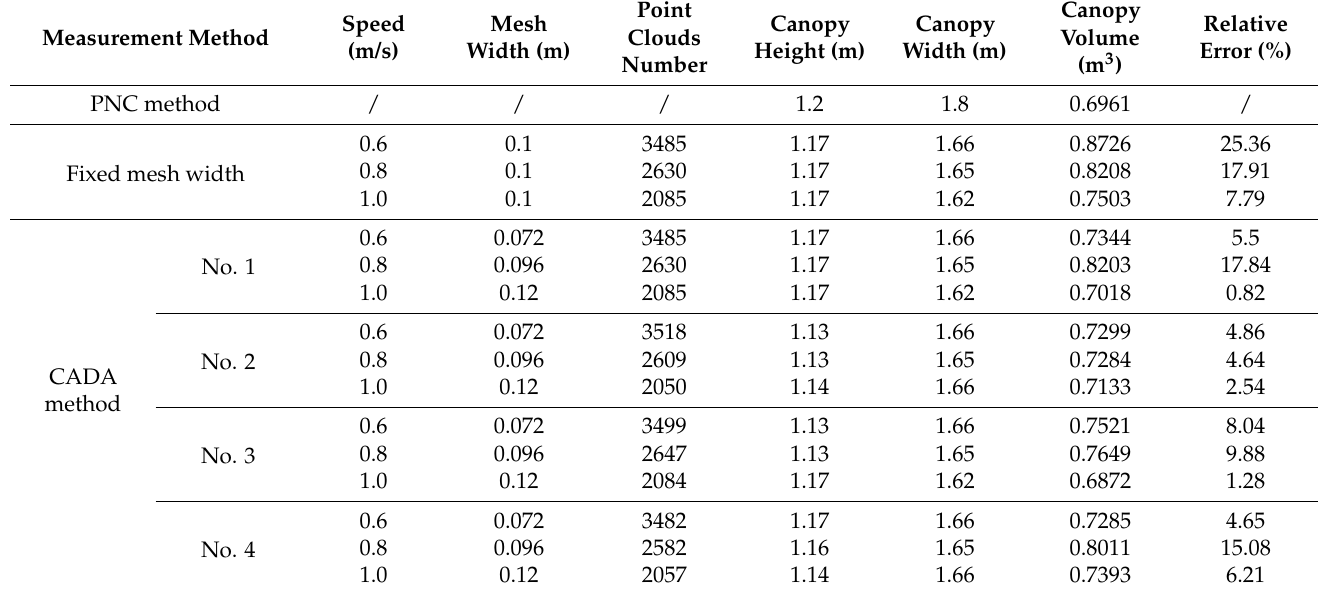
Table 5. Canopy volume detection results of the CADA method at different